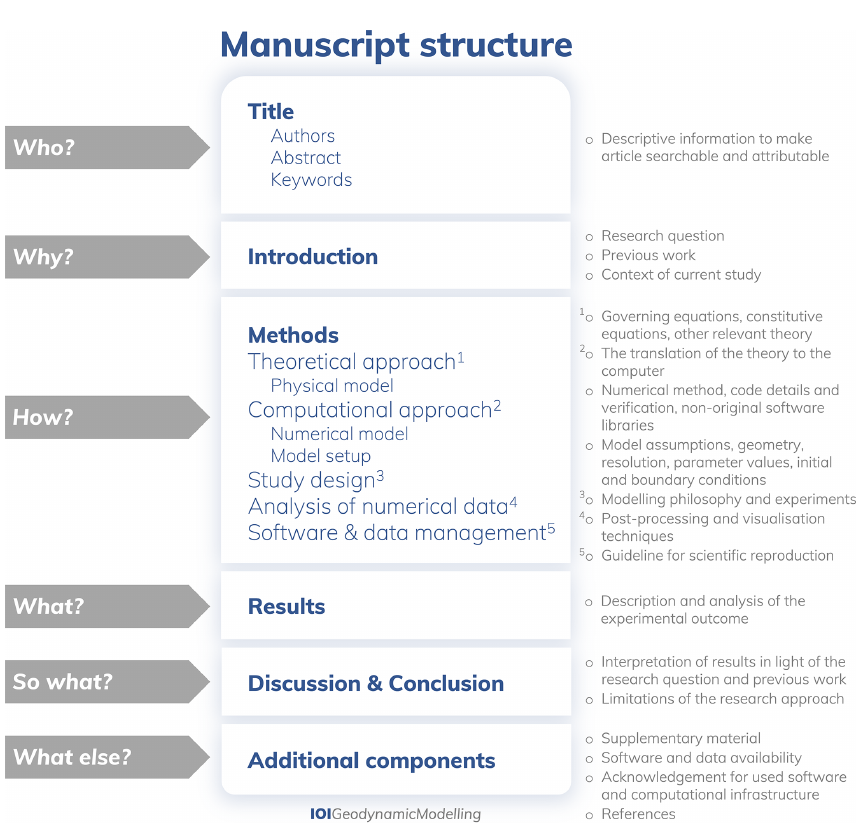
Figure 11. Manuscript structure for a geodynamic numerical modelling study following IMRAD . In particular, the methods section should include a description of the physical and numerical model, the design of the study, and of any techniques used to visualise and analyse the numerical